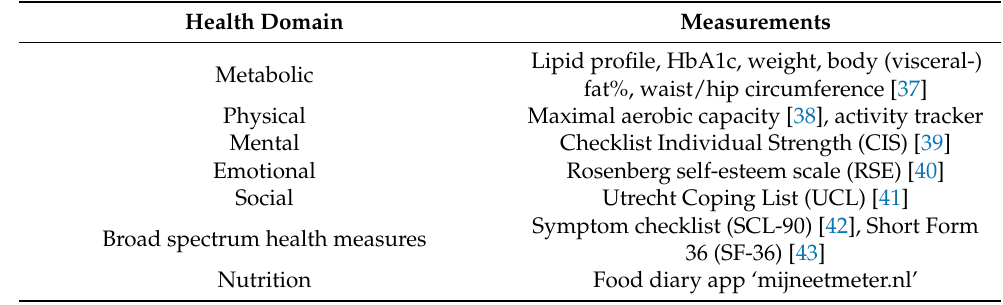
Table 2. Selection of the measurements per health